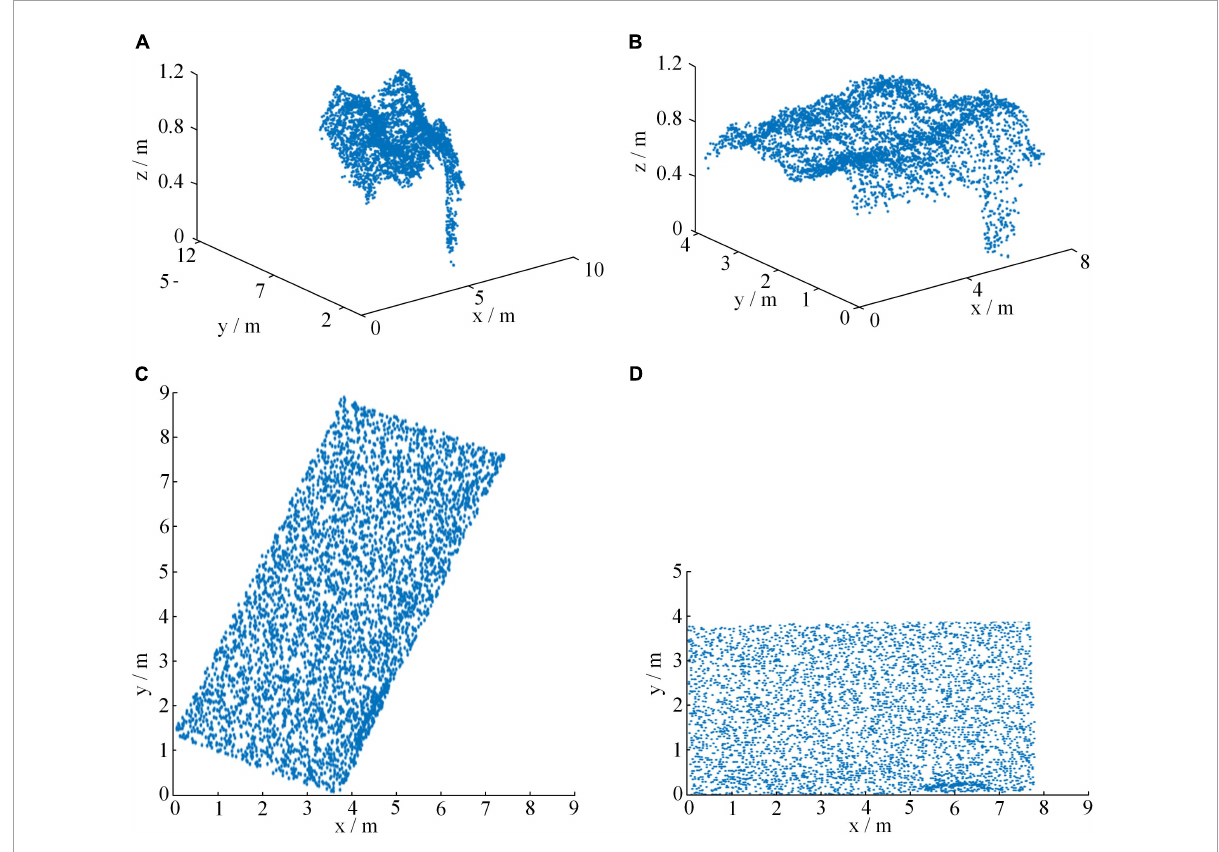
FIGURE10 Comparison of point clouds before and after Hotelling transform. (A) original three-dimensional view, (B) original bird’s eye view, (C) three-dimensional view after Hotelling transform, and (D) bird’s eye view after Hotelling transform.